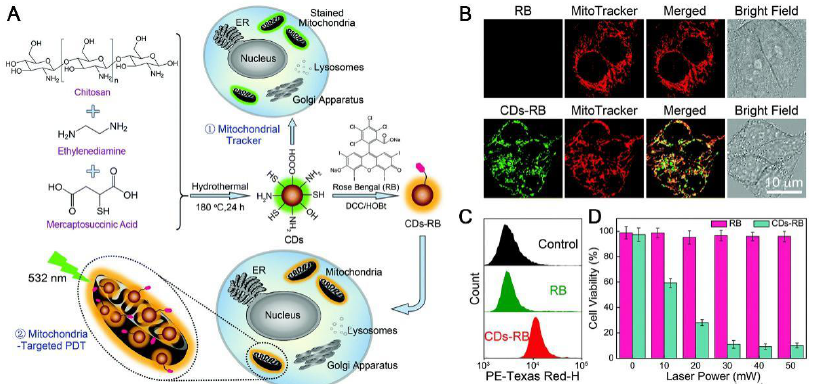
Figure 4. ( A ) Schematic illustrating the synthetic route of CDs and their applications as fluorescent mitochondrial trackers and mitochondria-targeting drug carriers (nanomissiles). ( B ) Confocal images of MCF-7 cells costained with MitoTracker (Ex: 638 nm) and free rose bengal (RB) (Ex: 552 nm) or costained with MitoTracker (Ex: 638 nm) and carbon dots (CDs)–RB (Ex: 488 nm). ( C ) Flow cytometric results of MCF-7 cells incubated without (control) and with free RB or CDs–RB. ( D ) The cell viability result of MCF-7 cells incubated with free RB or CDs–RB for 30 min, followed by washing with PBS twice and then irradiation using a 532 nm laser of different power intensities for 5 min. In cell experiments, free RB and CDs–RB were used at the same RB concentration (5 μg mL −1 ). Reproduced with permission from Ref. [111]. Copyright 2017 Royal Society of Chemistry.